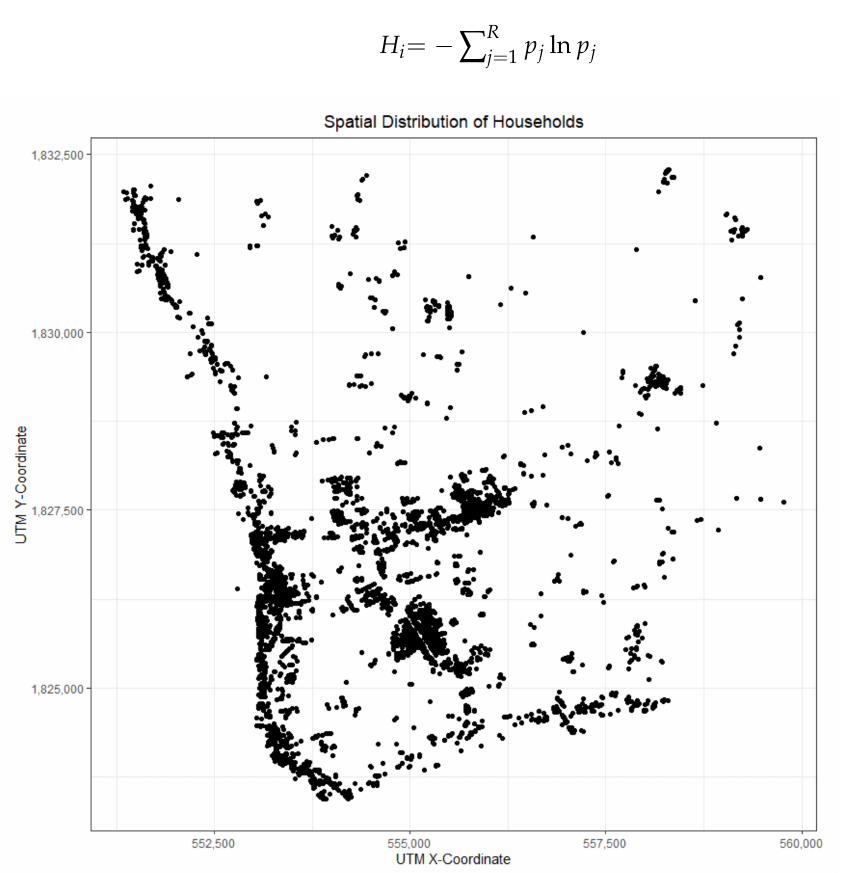
Figure 5. Spatial distribution of households in the study